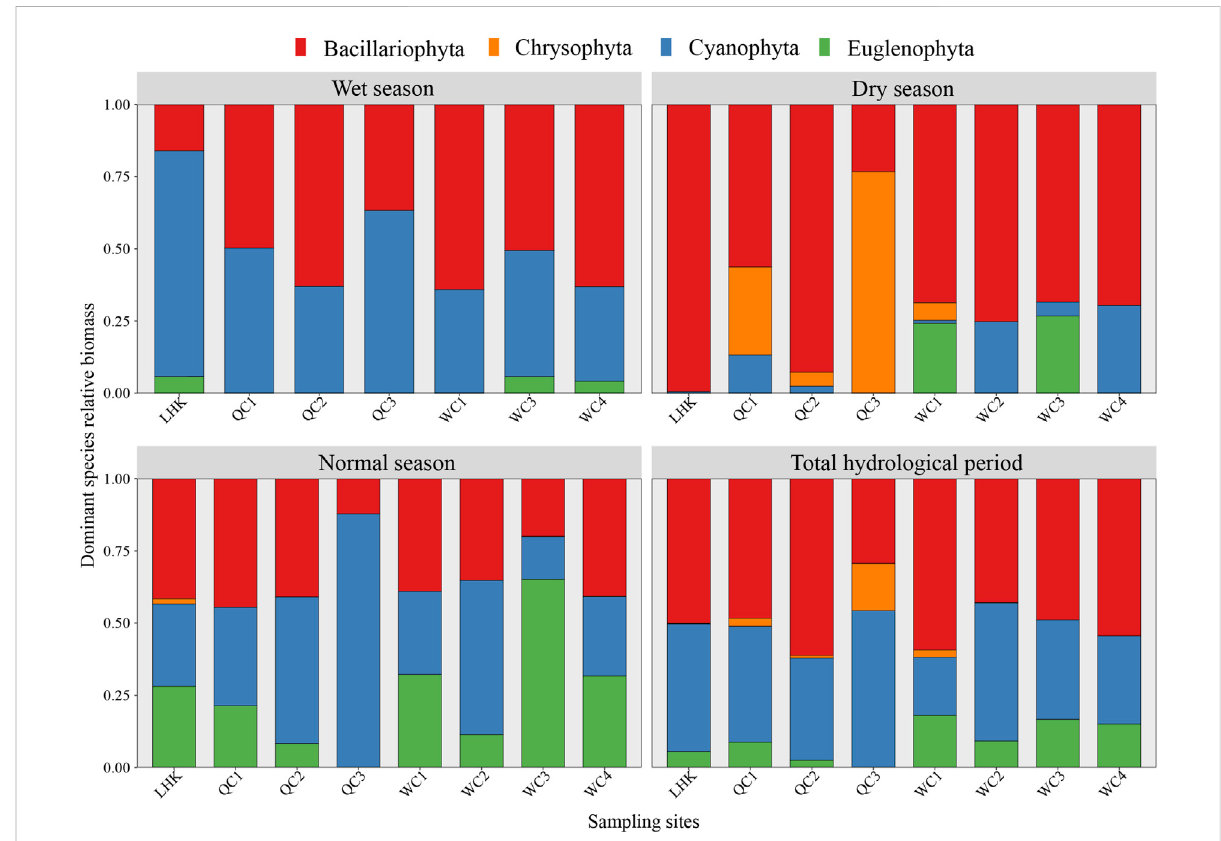
FIGURE 3 Spatial-temporal variation in the relative biomass of the dominant phytoplankton species in different hydrological seasons.